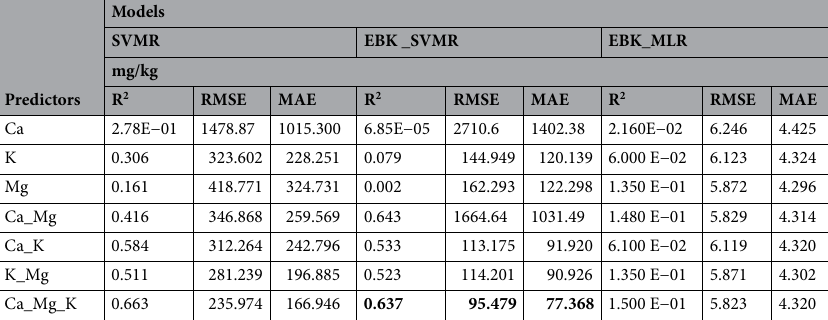
Table 3. Model comparison using diverse prediction models. Significant values are in bold.